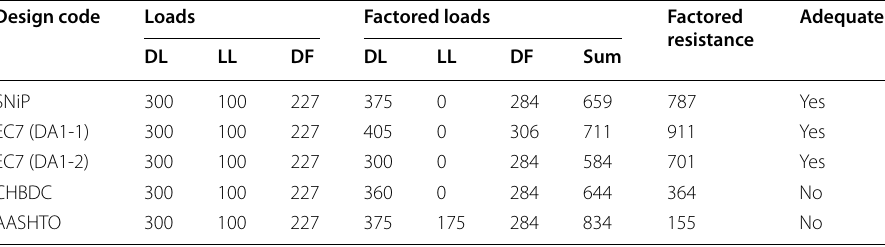
Table 4 Geotechnical ULS calculations according to design codes for Case II Design